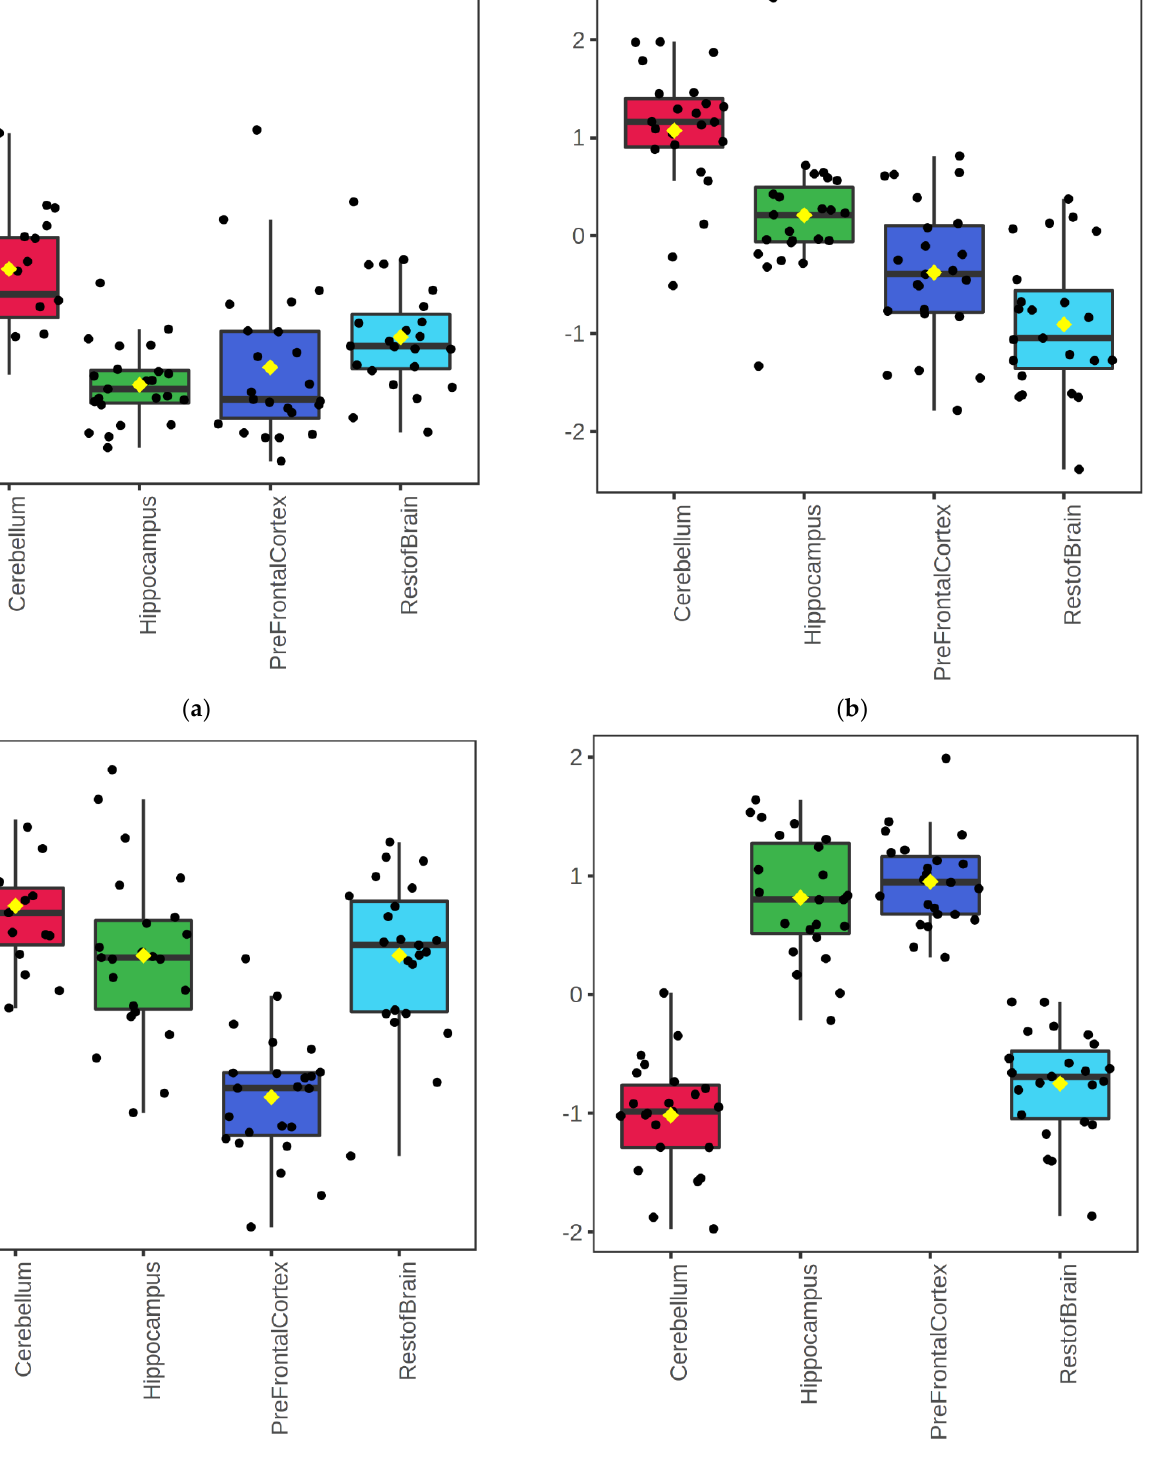
Figure 2. Boxplots of total lipid abundance at the lipid class level for four brain regions (cerebellum, hippocampus, prefrontal cortex, and the rest of the brain) in positive mode for triacylglycerides ( a ), lysophosphatidylcholines ( b ), sphingomyelin ( c ), and ceramides ( d ). Data shown are the sum of all peak areas per lipid class, log10 normalized and auto-scaled.